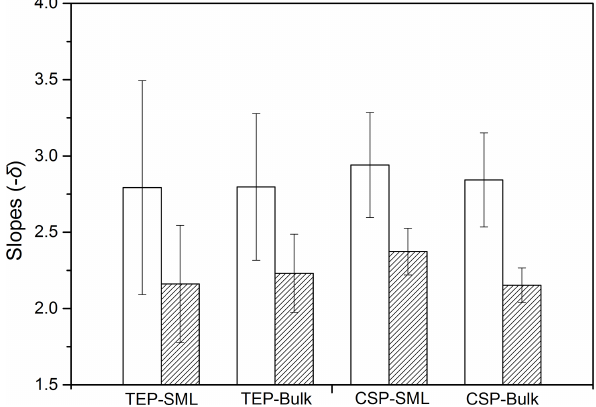
Figure 7. Average slopes of gel particles in the bulk water and SML. Open bars: before addition of E. huxleyi ; hatched bars: after addition of E. huxleyi ; error bars indicate ±